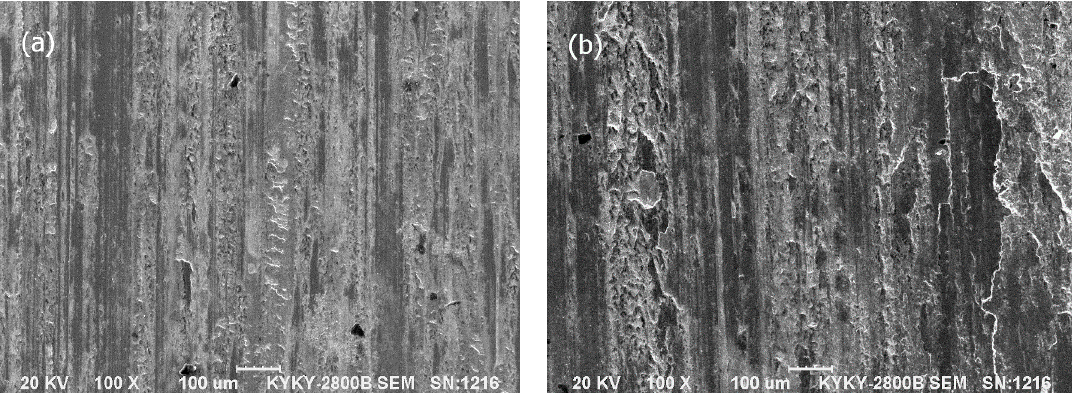
Figure 7. SEM micrographs showing the worn surface morphologies of the hardened 0.45%C steel ( a )